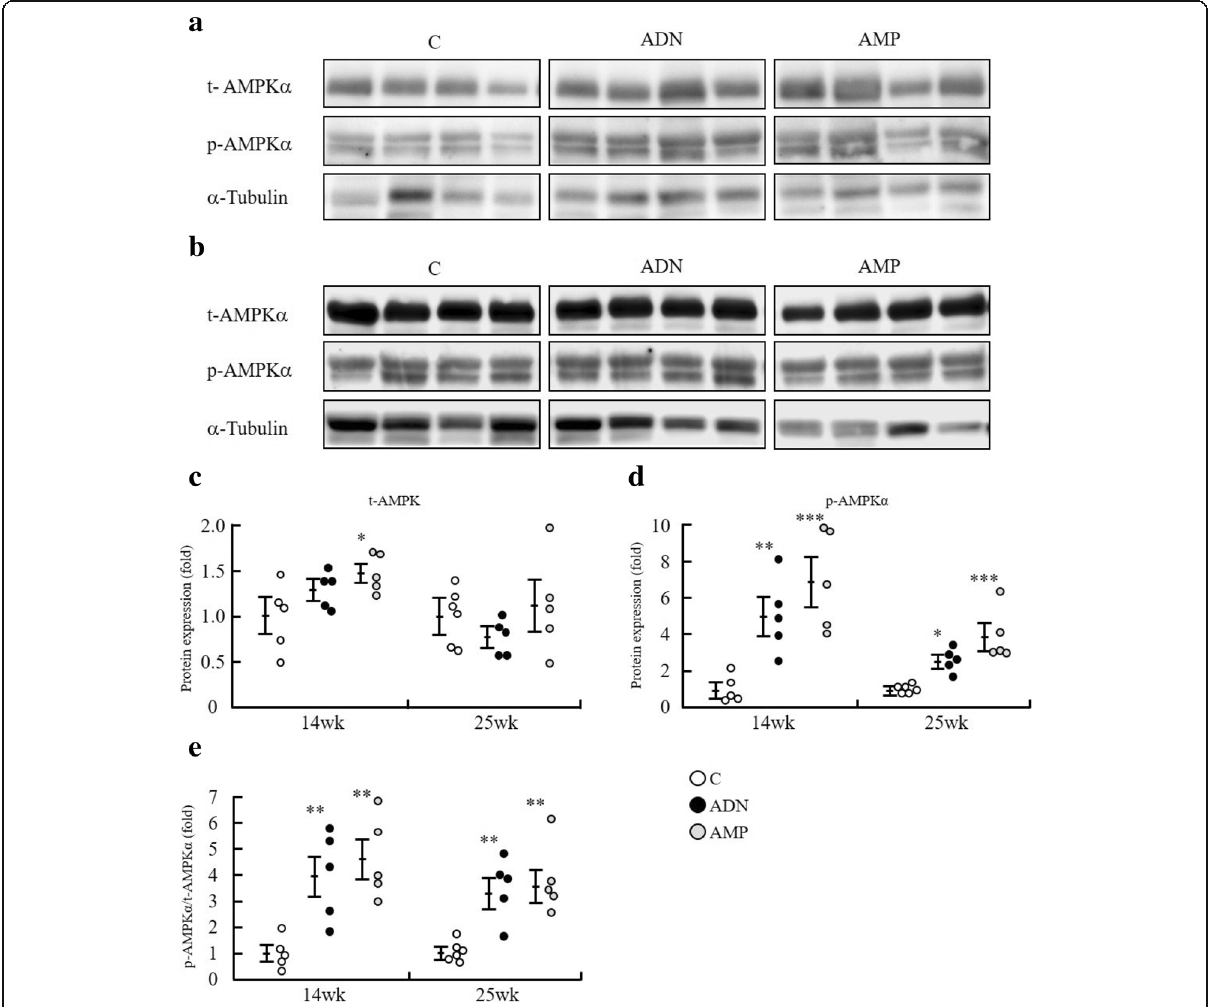
Fig. 5 Representative immunoblot images and quantitative analyses of total AMPK α , phosphorylated AMPK α , and α -tubulin. a Western blot images at 14 weeks; ( b ) western blot images at 25 weeks; ( c ) expression of total AMPK α (t-AMPK α ); ( d ) expression of phosphorylated AMPK α (p-AMPK α ); and ( e ) ratio of t-AMPK α to p-AMPK α . Values are means ± SEM, n = 5 or 6. * p < 0.05, ** p < 0.01, *** p < 0.001 versus the control group. C, control group; ADN, adenosine group; AMP, adenosine-5 ′ -monophosphate